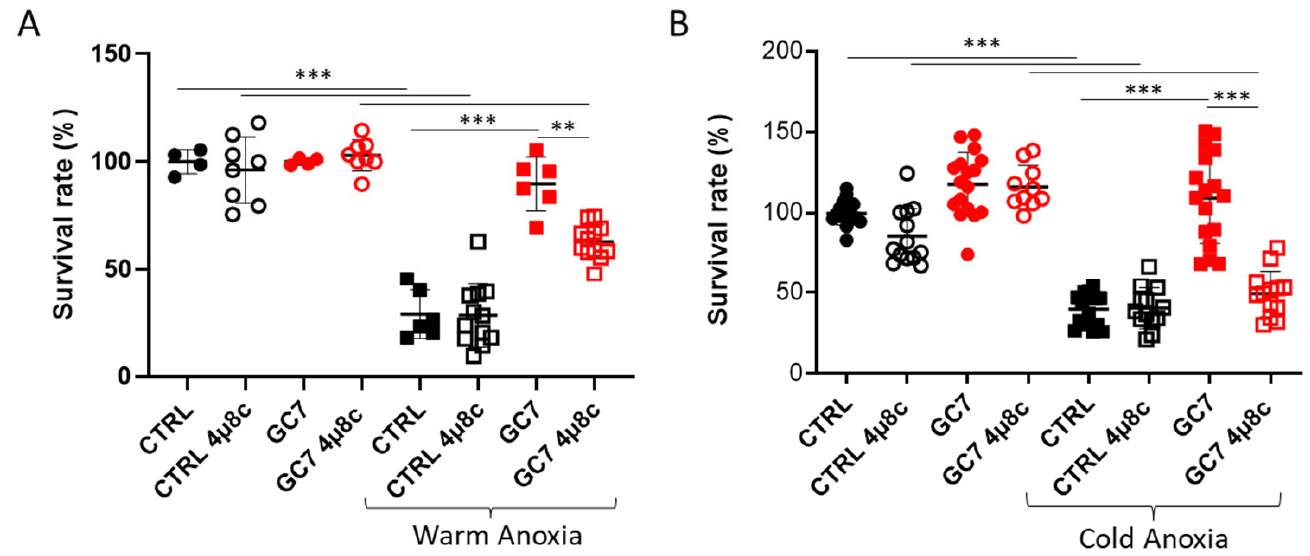
Figure 5. 4 µ 8c inhibition of IRE-1 α hampered GC7 protective effect to anoxia. PCT cells Figure 5. 4 μ 8c inhibition of IRE ‐ 1 α hampered GC7 protective effect to anoxia. PCT cells pretreated for 8 h either with a vehicle or with 30 μ M GC7 and 24 h later exposed to either ( A ) warm (37 °C, 24 h) or ( B ) cold (4 °C, 16 h) anoxia ( ≤ 0.1% O 2 ), in presence or not of 1 μ M of the IRE ‐ 1 α inhibitor 4 μ 8c. At the end of the experiment, cell viability was evaluated using a live/dead fluorescence assay. Scat ‐ ter plot representation of individual values along with mean ± SD for each condition, n = 6–12. ** = p ≤ 0.001; ***= p ≤ 0.0001.